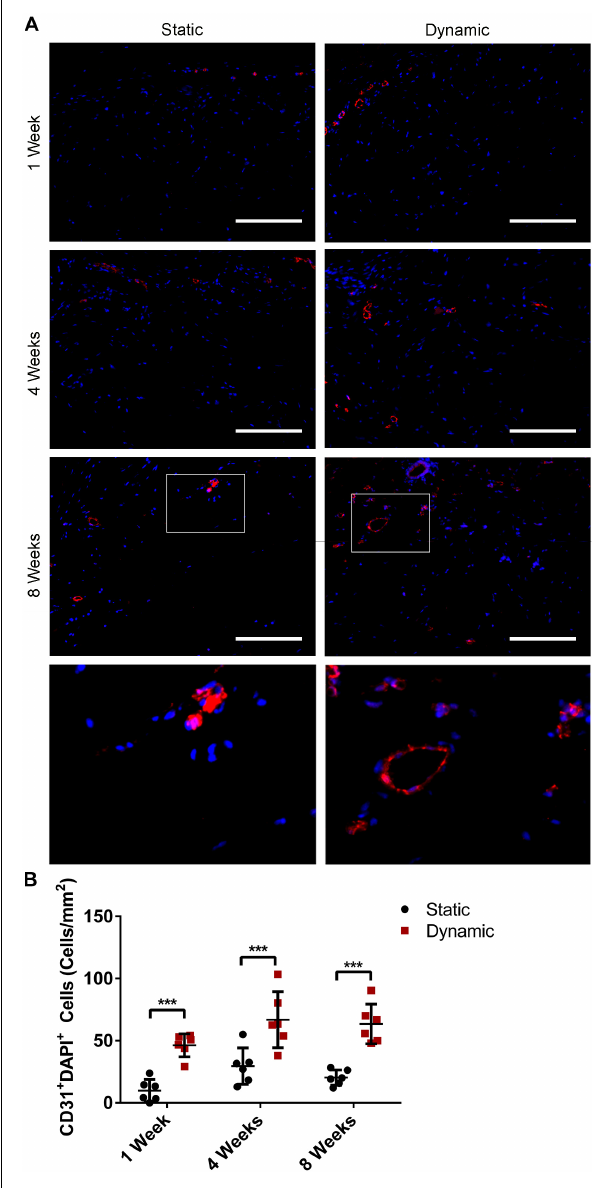
FIGURE 4 | Dynamic culture of ASCs on the DAT scaffolds enhanced CD31 + cell recruitment following implantation in the nu/nu mouse model. (A) Representative immunostaining showing CD31 (red) with DAPI counterstaining (blue) within the DAT implants for both the static and dynamic groups at 1-, 4- and 8-weeks post-implantation. Scale bars represent 100 µ m. Boxed regions in the 8-week images are shown at higher magnification below. (B) CD31 + DAPI + endothelial cell density in the implants. *** p < 0.001.